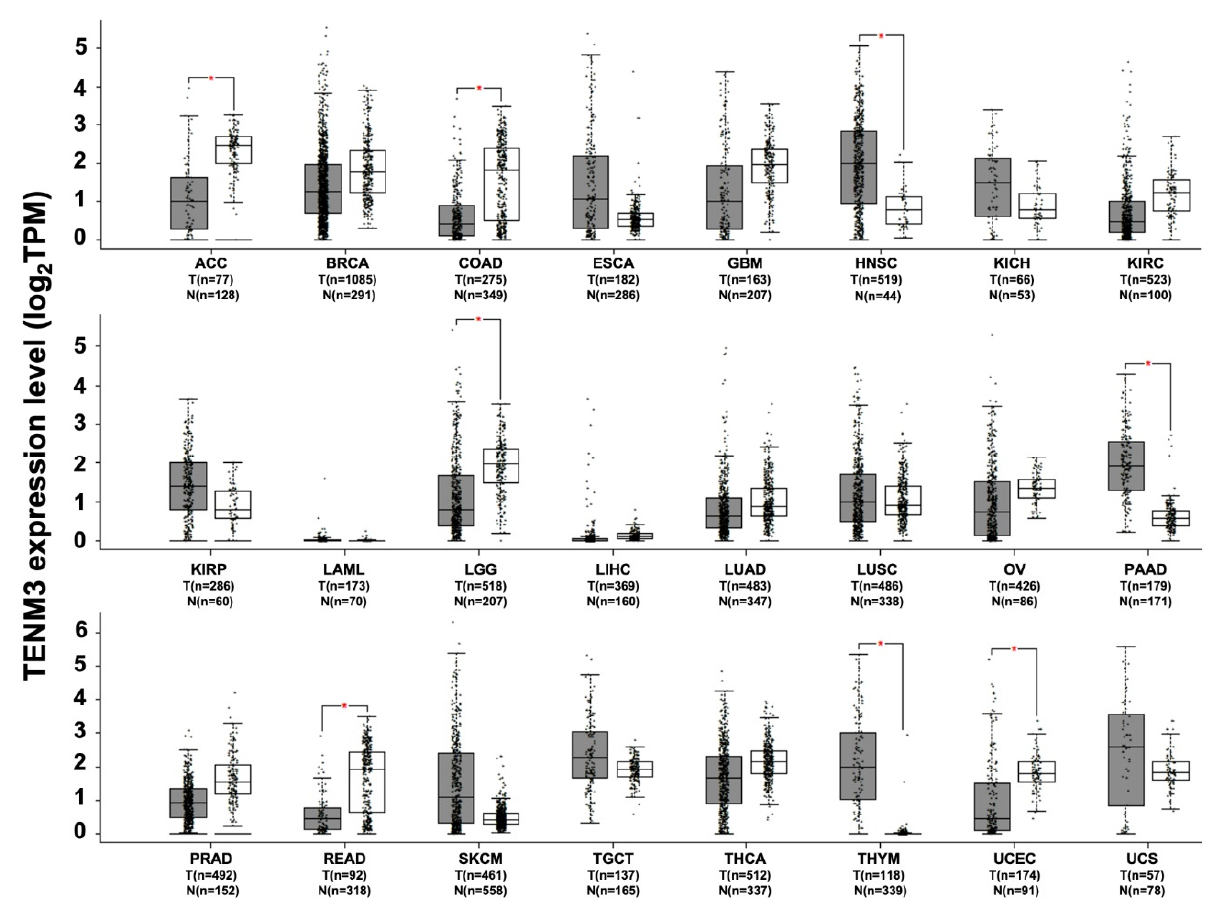
Figure 4. TENM3 expression in different datasets of tumors and normal samples. TENM3 expression level, shown as log2 of transcript per million mapped reads value, was analyzed from RNA sequencing data of tumors and normal samples from the TCGA and the GTEx projects, using a web standard processing pipeline [43]. Tumor (T) and normal samples (N) are represented in grey and white box plots, respectively, each dot representing a sample ( n = number of sample within the dataset). Statistical differential analysis was performed using the GEPIA default recommended parameters, one-way ANOVA, |Log2FC| ≥ 1 and p ≤ 0.01. Datasets description: ACC; Adrenocortical carcinoma. BRCA; Breast invasive carcinoma. COAD; Colon adenocarcinoma. ESCA; Esophageal carcinoma. GBM; Glioblastoma multiforme. HNSC; Head and neck squamous cell carcinoma. KICH; Kidney chromophobe. KIRC; Kidney renal clear cell carcinoma. KIRP; Kidney renal papillary cell carcinoma. LAML; Acute myeloid leukemia. LGG; Brain lower grade glioma. LIHC; Liver hepatocellular carcinoma. LUAD; Lung adenocarcinoma. LUSC; Lung squamous cell carcinoma. OV; Ovarian serous cystadenocarcinoma. PAAD; Pancreatic adenocarcinoma. PRAD; Prostate adenocarcinoma. READ; Rectum adenocarcinoma. SKCM; Skin cutaneous melanoma. TGCT; Testicular germ cell tumors. THCA; Thyroid carcinoma. THYM; Thymoma. UCEC; Uterine corpus endometrial carcinoma. UCS; Uterine carcinosarcoma.